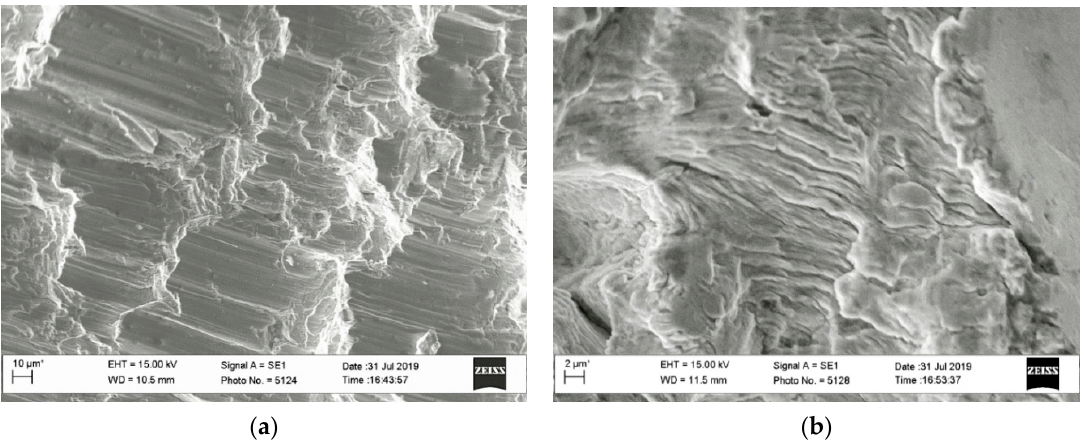
( d ) Figure 13. Profiles of the fracture surfaces of mode I ‐ III test specimens: ( a ) Overview; ( b ), ( c ), ( d ) fracture features on the macro ‐ level of the specimens. The zones of the initial stage of the fatigue crack growth, its accelerated growth, when the angle of inclination of the fracture surfaces became more noticeable, and spontaneous growth zones were observed on the macro fracture surfaces of the specimens (Figure 13a). The fatigue crack growth features at the micro ‐ level were analyzed at the center parts of the fracture surfaces of the specimens